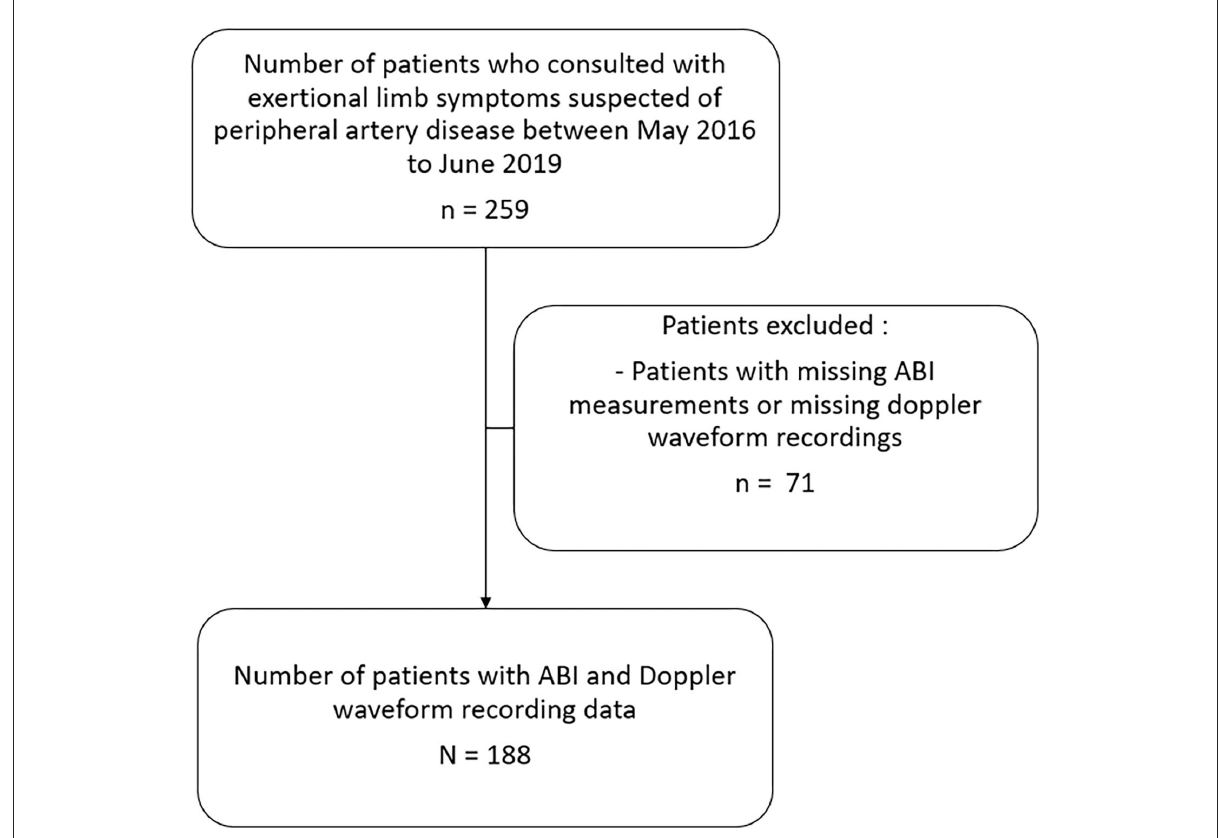
FIGURE1 Diagram flow of the study. This figure shows the selection process of the study. Patients were excluded if there were missing ABI and missing arterial Doppler waveform. ABI means ankle brachial